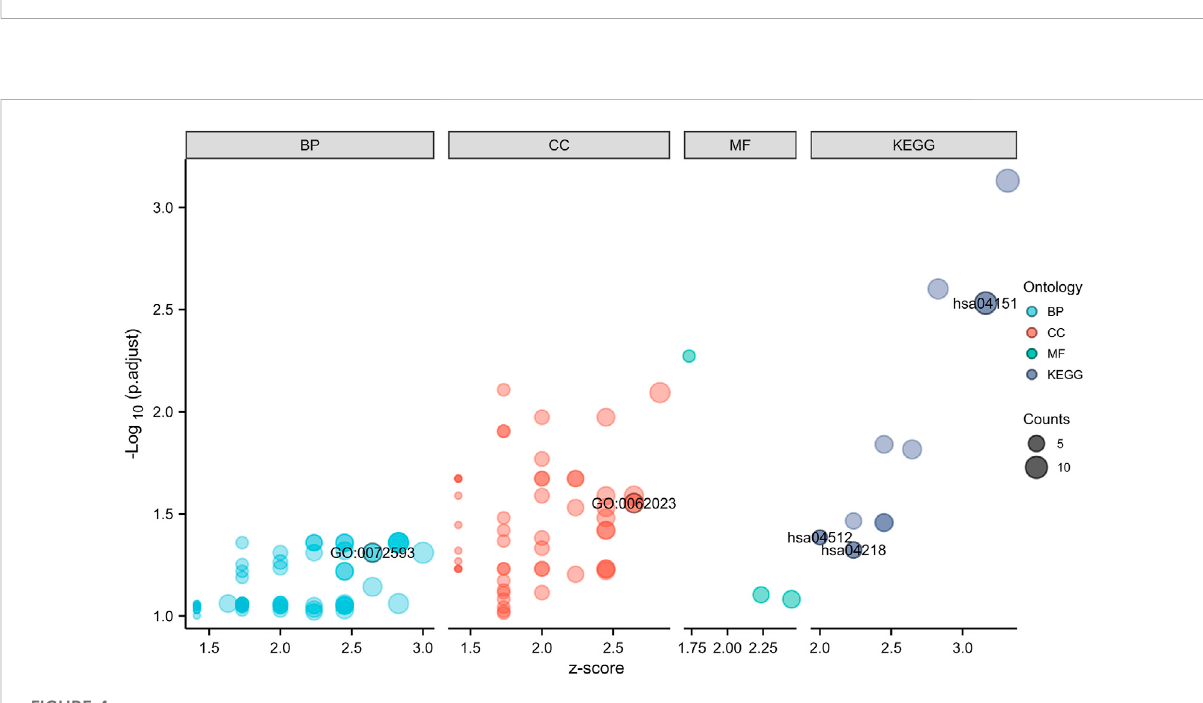
FIGURE 4 GO and KEGG enrichment analyses of hub